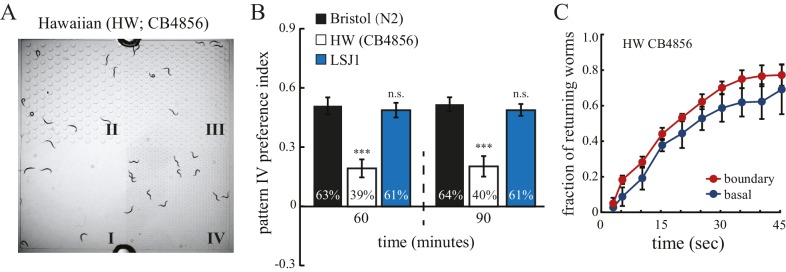
Hawaiian strain does not select pattern IV.(A) The Hawaiian CB4856 strain (HW) does not show significant preference for pattern IV of the quad-chamber. The representative image was taken at 60 min after the worms were loaded into the chamber. (B) Quantification of the preference for pattern IV of N2, HW, and LSJ1 (a sibling of the N2 strain) worms in the quad-chamber at 60 and 90 min. n = 12. (C) HW CB4856 worms do not show enhanced returning at boundaries. n = 6. Data were collected as described in Figure 2B.